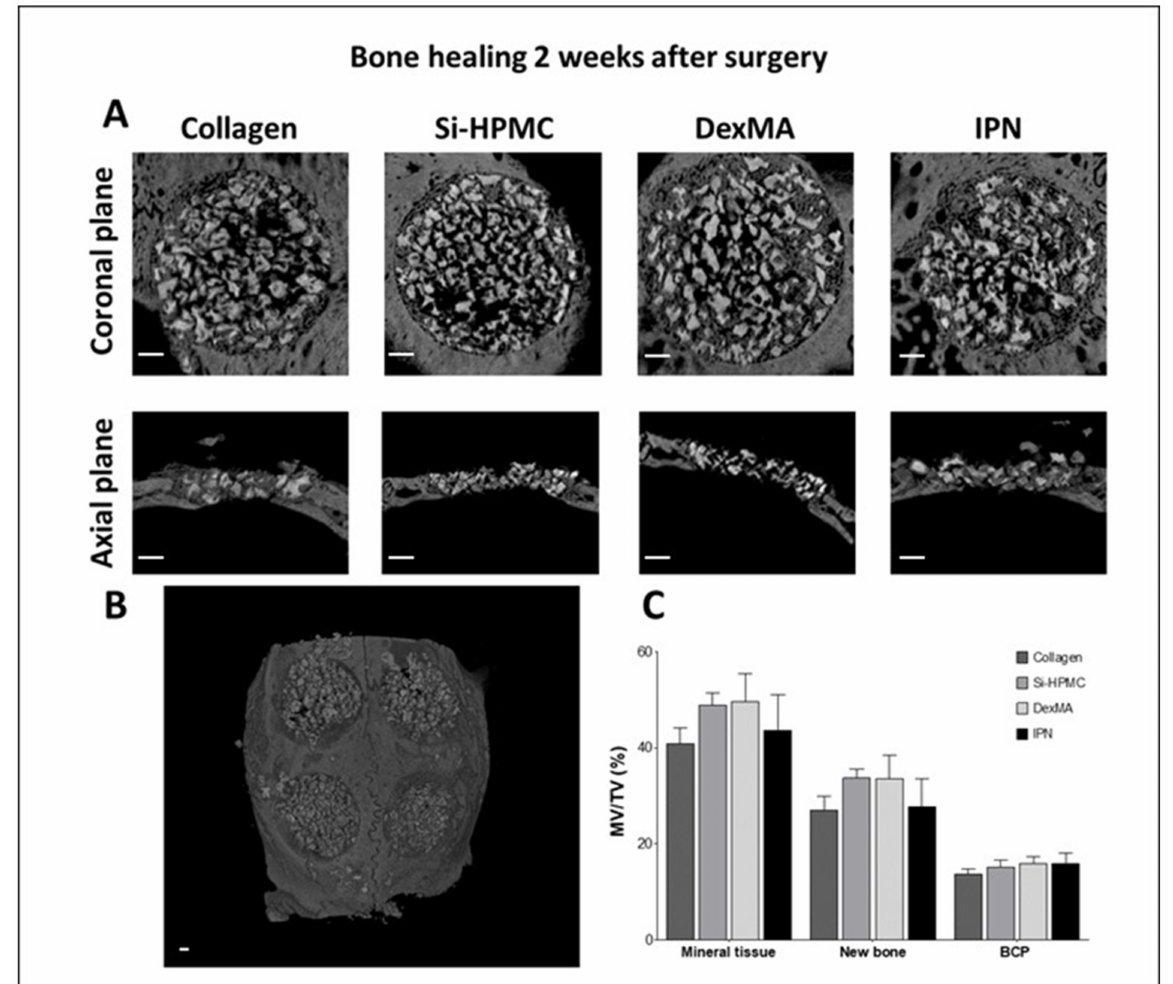
Figure 7. Bone healing evaluation 2 weeks after implantation ( A ) Micro-CT imaging of the calvaria defects with diameters of 8 mm ( B ) 3D reconstruction of the external view of calvaria. Clockwise from top left: control collagen membrane, IPN, DexMA, and Si-HPMC. ( C ) Quantification of the percentage of mineral volume versus the total volume (MV/TV) of the total mineral tissue, new bone, and biphasic calcium phosphate granules (BCP) in the volume of interest. Error bars represent the standard deviations of the means ( n = 6). Si-HPMC: silanized hydroxypropyl methylcellulose, DexMA: dextran methacrylate, IPN: interpenetrating polymer network. No statistical difference was found between the groups. (Scale bar: 1